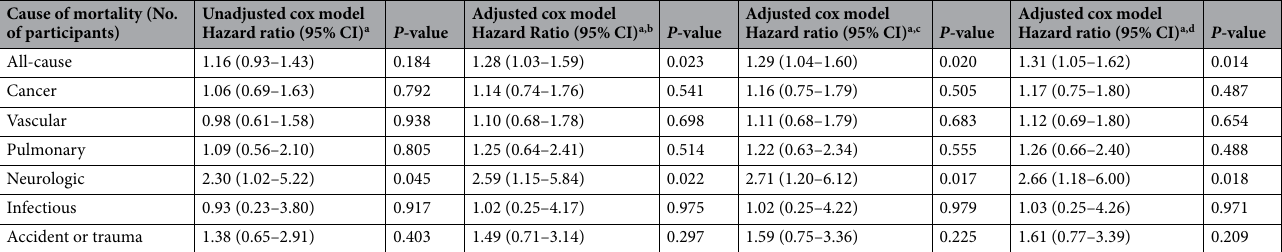
Table 3. Hazard ratios of total and cause-specific mortality in Korean elderly patients according to history of glaucoma surgery. CI confidence interval, DM diabetes mellitus. a Cox model with vitreoretinal surgery status as a time-varying covariate. b Adjusted for age and sex. c Adjusted for age, sex, income, region, Charlson Comorbidity Index score (0, 1, 2, 3, 4, ≥ 5), age-related macular degeneration, DM with ophthalmic manifestations, and cataract severity. d Adjusted for age, sex, income, region, Charlson Comorbidity Index score (0, 1, 2, 3, 4, ≥ 5), age-related macular degeneration, DM with ophthalmic manifestations, cataract severity, smoking, drinking, exercise, and body mass